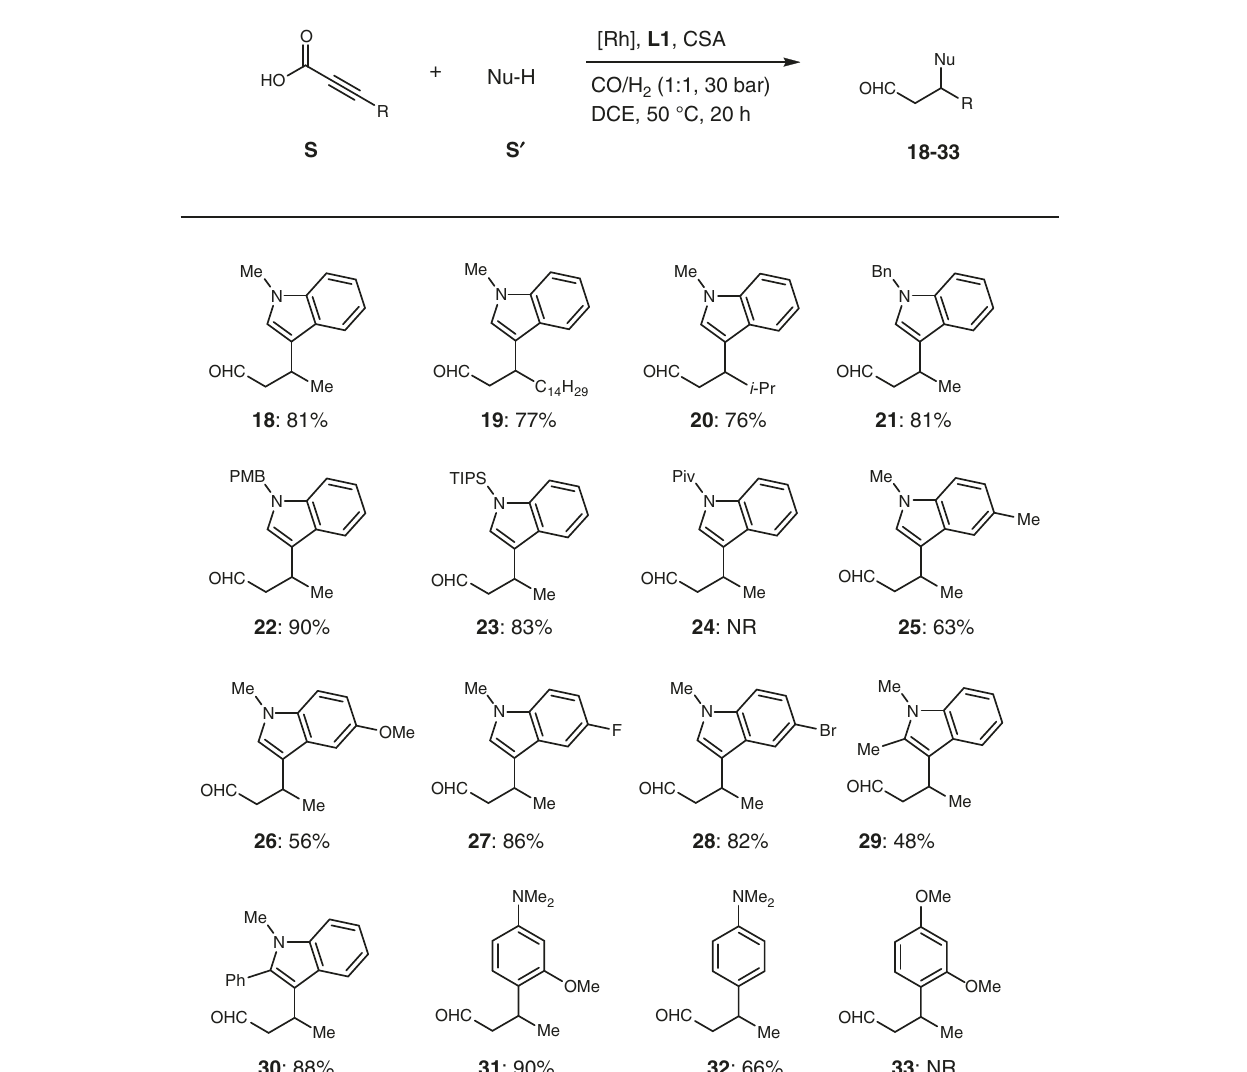
Table 3 Substrate scope of indole derivatives and other nucleophiles a